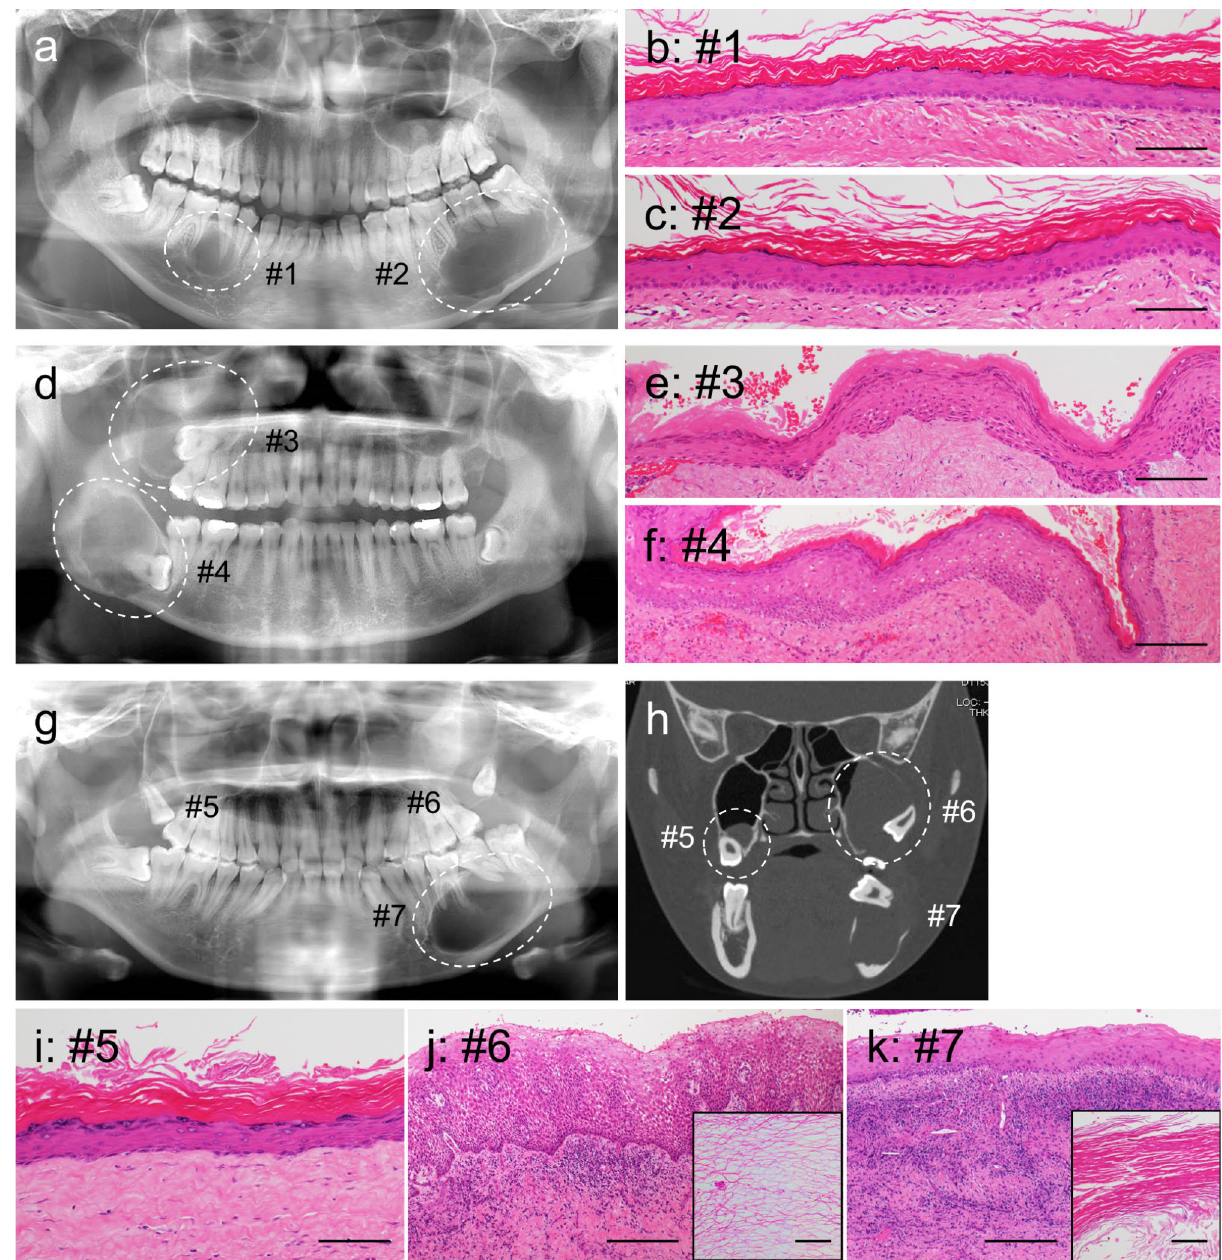
Fig. 1 Radiographic and histological analyses of multiple OOC. Panoramic radiographs of Case 1 ( a ), 2 ( d ), and 3 ( g ), and coronal CT of Case 3 ( h ). The OOCs show a well-demarcated, unilocular lesion (dotted line). Representative histological findings in Cases 1 ( b, c ), 2 ( e, f ), and 3 ( i-k ). The epithelial lining of OOC shows orthokeratinization with prominent granular cells. The lumen was filled with keratin material (insets i and k ). OOC, orthokeratinized odontogenic cysts; CT, computed tomography. Scale bars: 100 μm in Figs. b, c, e, f, i, j and